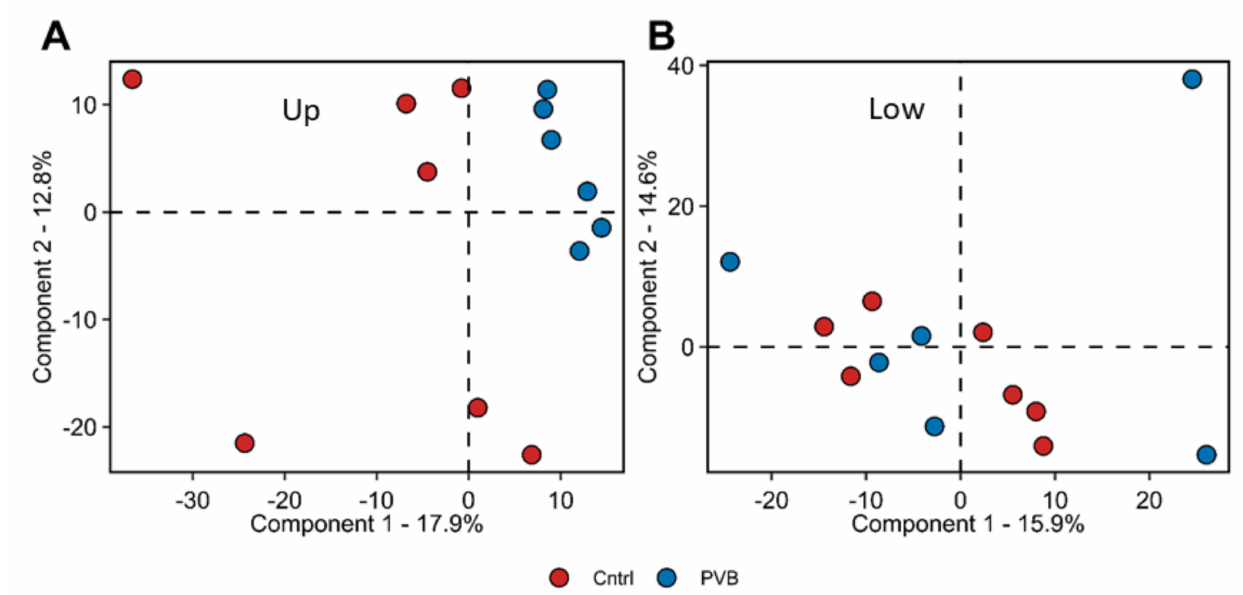
Figure 2. Proteomic analysis of lung tissue of PVB vs. Cntrl animals. ( A , B ) Principal component analysis (PCA) of proteome profiles from upper ( A ) and lower ( B ) lobe of Cntrl (n = 7) and PVB animals (n = 6). Colored circles indicate individual animals. Red-filled circles are Cntrl and blue-filled circles are PVB